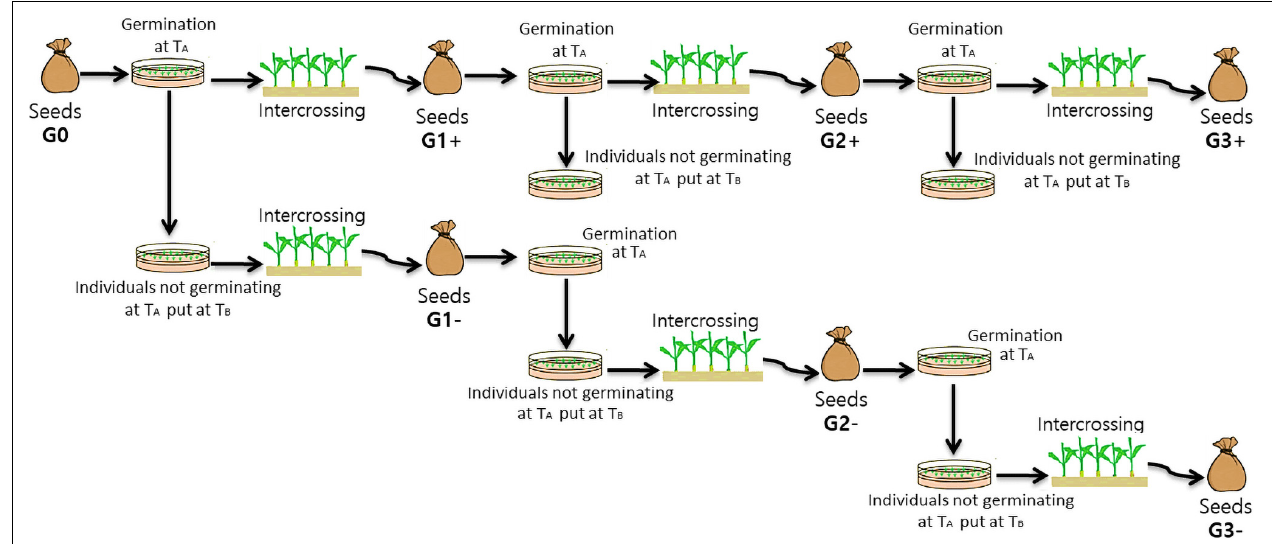
FIGURE 2 | Diagram illustrating the steps of the divergent selections for the capacity to germinate or not at an unfavourable temperature. From G0 seeds (initial generation/generation 0) to G3 seeds (third generation of selection) (T A = Unfavourable temperature = 10 ◦ C or 32 ◦ C and T B = Optimum temperature = 25 ◦ C).